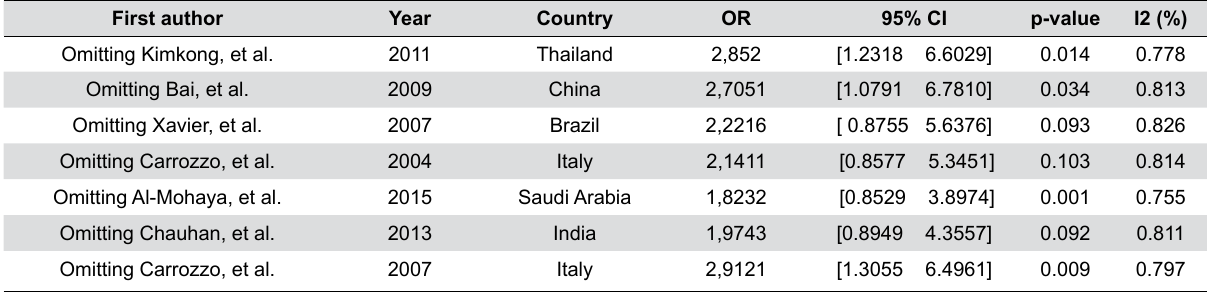
Table 2- Summary results of the sensitivity analysis